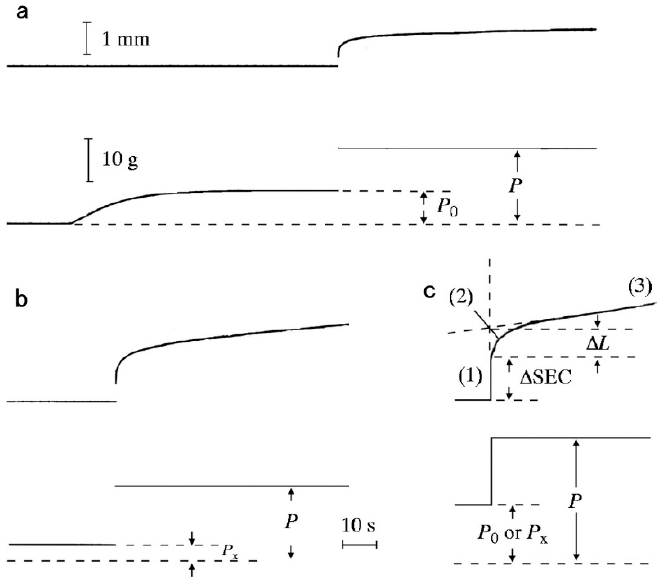
Figure 3. Length (upper traces) and tension (lower traces) changes to quick increases in load in the ABRM fibers producing active tension (Po) ( a ), and during the maintenance of catch tension P x ( b ). The magnitude of quick increase in load was from Po to 2.3 Po in ( a ), and from P x to P = 4.3 P x in ( b ). In ( c ), the early part of the tension change to a quick increase in load, consisting of phases (1) to (3), is illustrated. (Mukou et al. [21]).